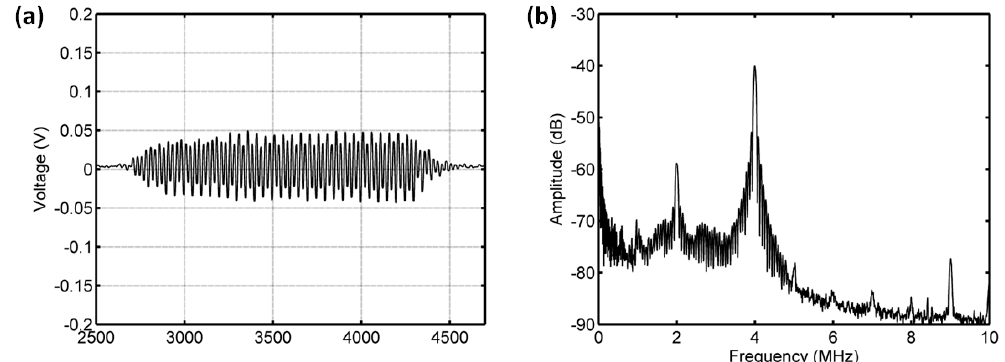
Figure 15. The measured scattering signals from microbubbles and the averaged power spectrum of 50 received signals. ( a ) A single received signal, ( b ) the averaged power spectrum. The driving frequency was 4 MHz, the acoustic pressure was 500 kPa, and the overpressure was 180 mmHg.